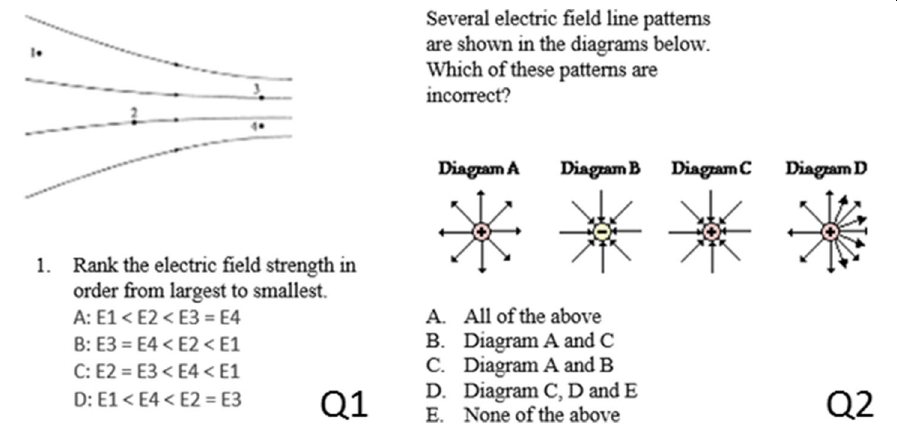
Fig. 3 Questions for general understanding. Q1 Source: http://dev.physicslab.org/Document.aspx?doctype=3 &filename=Electrostatics_ContinuousChargedRod.xml. Q2 Source: